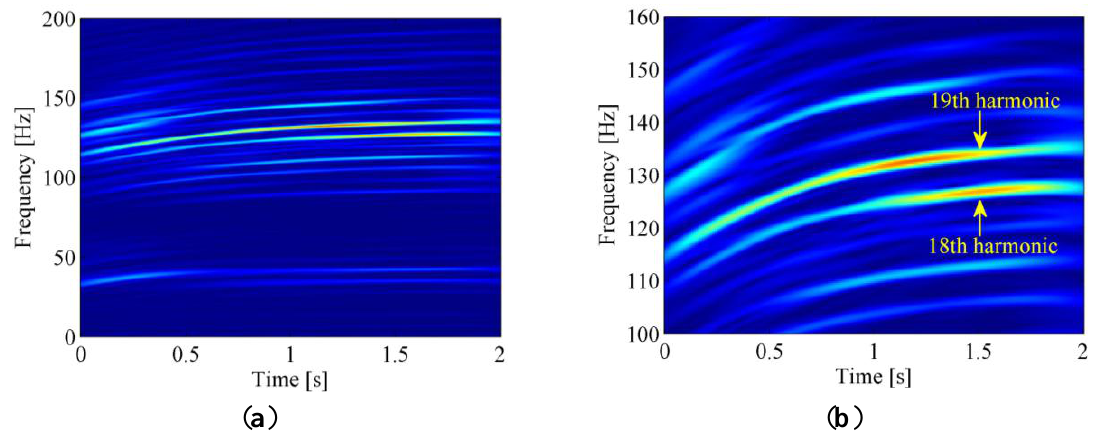
Figure 14. The ASTFT spectrogram of the bearing signal: ( a ) Overview; ( b ) Zoomed in 100–160 Hz.